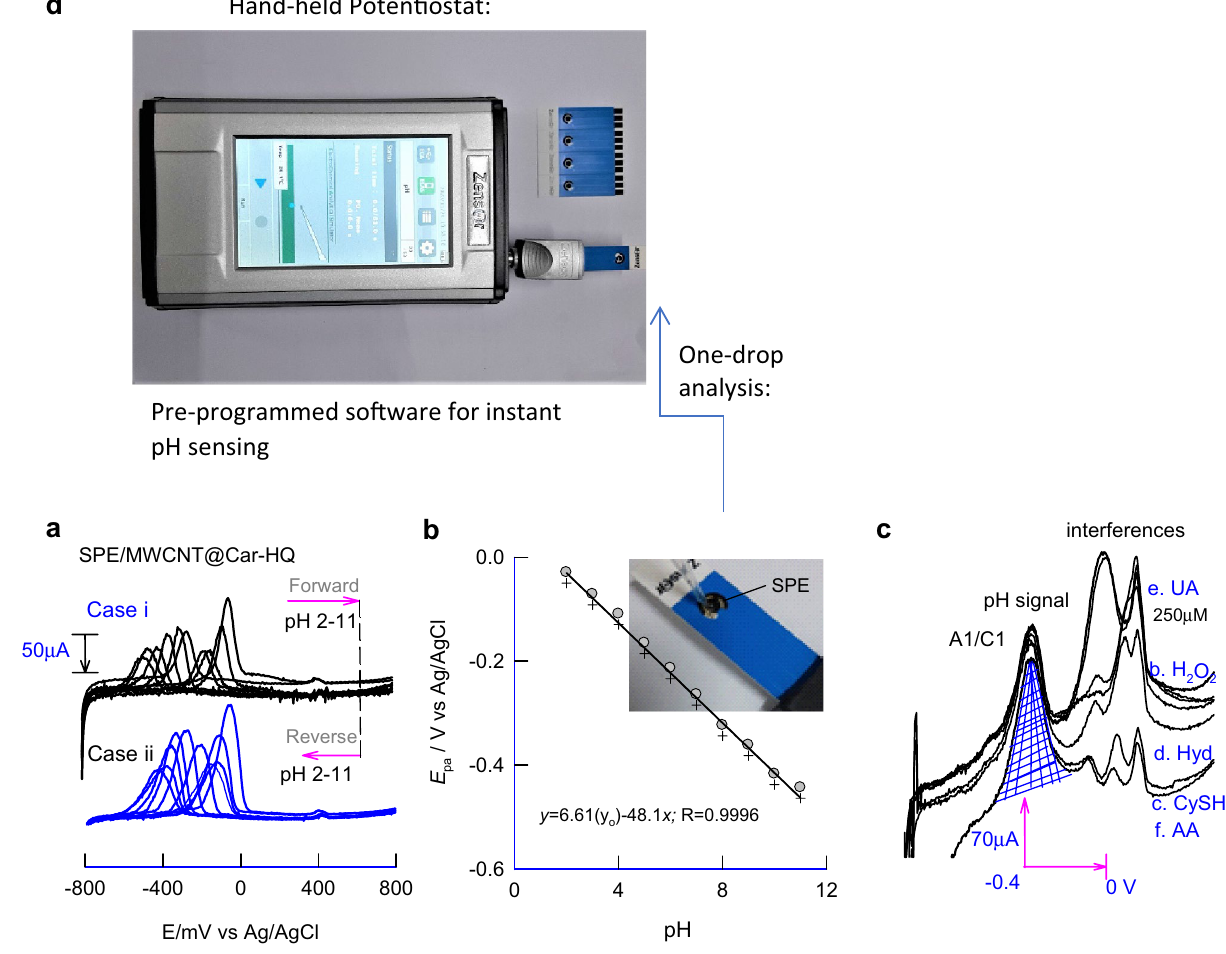
Figure 7. DPV responses of SPE/MWCNT@Car-HQ modified with one drop of; ( a ) different pHs tested by forward and reverse sweeping and ( c ) with various interfering chemicals. ( b ) is a corresponding plot of E p versus pH of the solution. ( d ) Photo graph of hand-held potentiostat compatible for SPE and preprogrammed software for instant pH sensing applications. Photographs were taken by the first